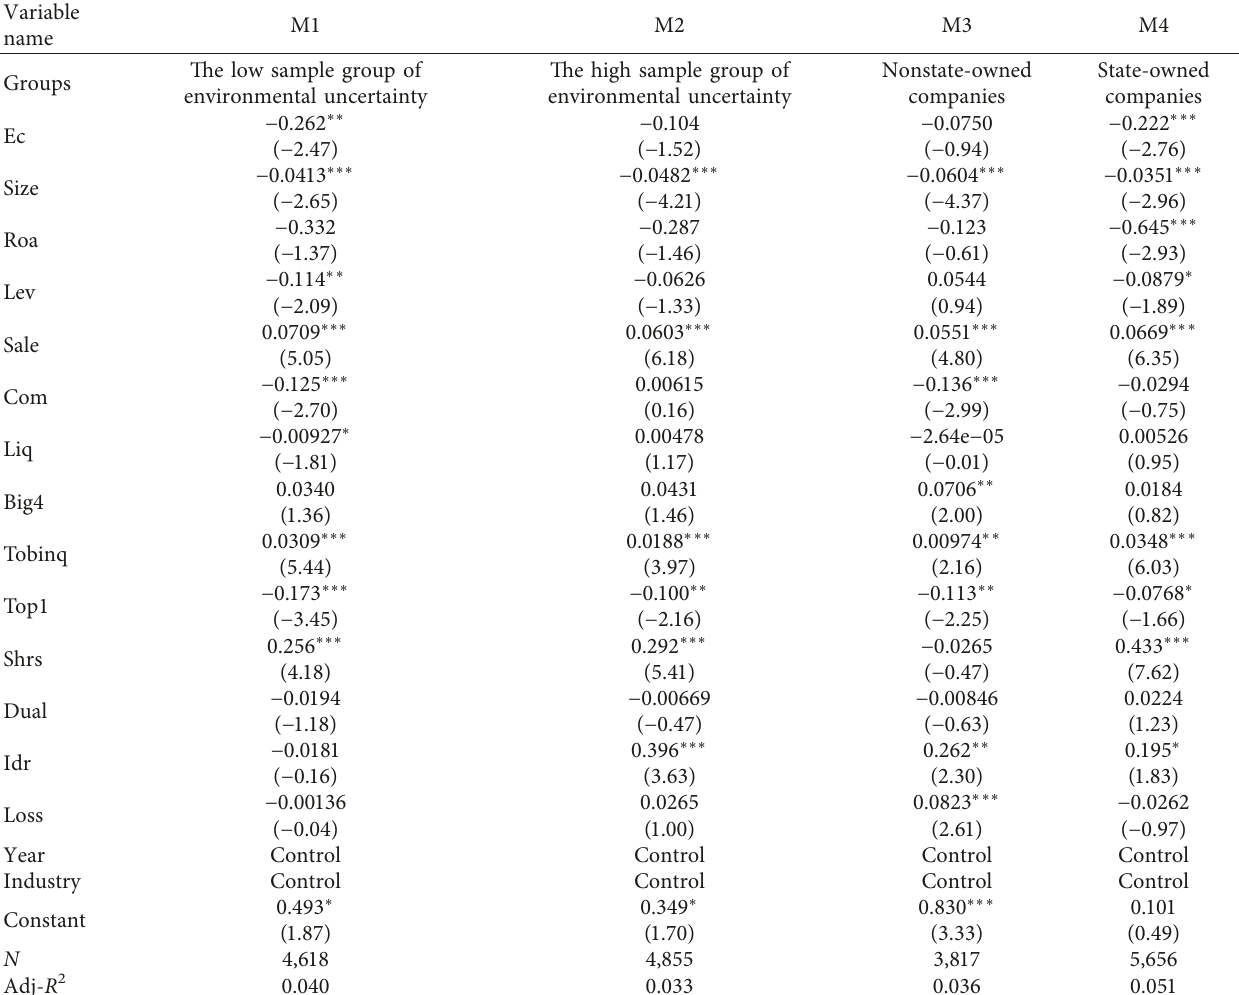
Table 5: Group test of OLS regression results.